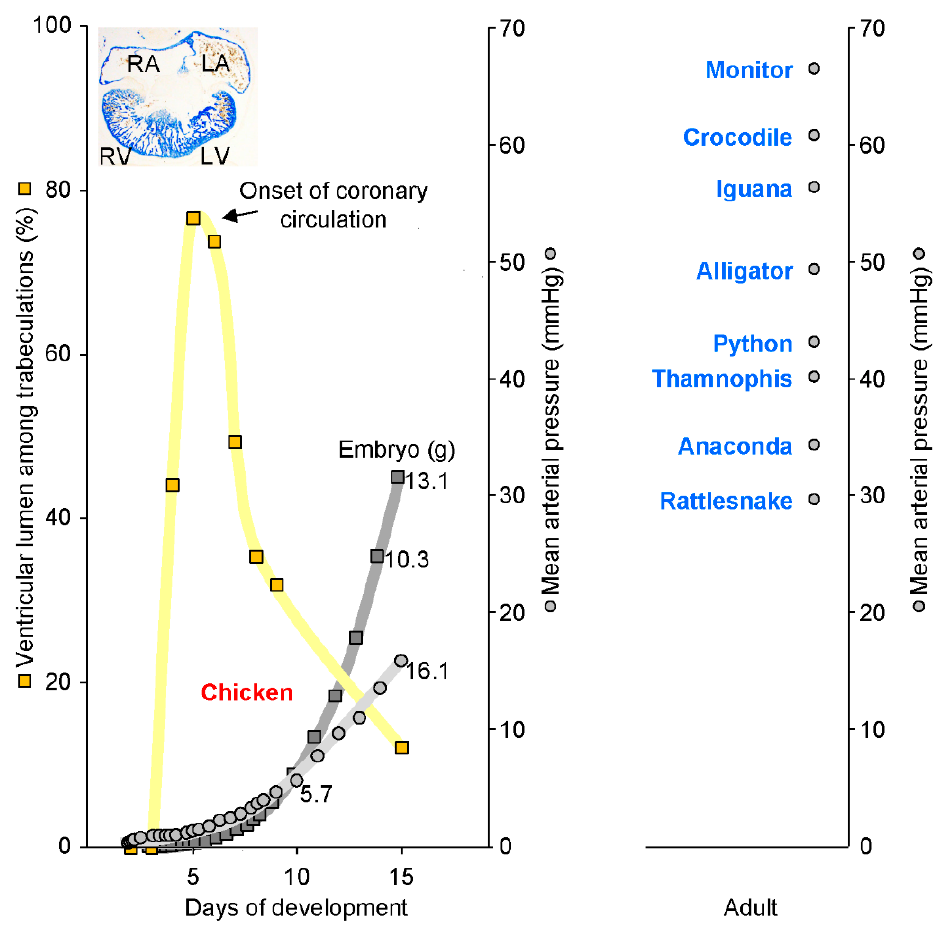
Figure 2. Highly trabeculated ventricles are capable of generating very substantial blood pressures. The left panel shows the in ovo development in chicken embryos of body mass (dark grey) and blood pressure (grey). In parallel, the wall architecture (yellow) changes from heart tube (2 to 3 days), to highly trabeculated (6 to 7 days), and to predominantly compact (15 days). The insert shows the highly trabeculated left (LV) and right ventricle (RV) at 6 days of development (and the almost a-trabecular left (LA) and right atrium (RA)). From approximately 6 days onwards, when blood pressure is about 3 mmHg, trabeculations and blood pressure become inversely related. The right-hand panel, however, shows that ectotherms have much greater blood pressures than developing chicken despite having highly trabeculated ventricles. Assuming that the cardiac mass is a fixed proportion of embryonic weight, which it is in a human [57], blood pressure will have a tight relation to cardiac mass (R 2 = 0.96, blood pressure and embryo weight). In the left panel, values for body mass and blood pressure are from Reference [58] and values for ventricular wall architecture are from Reference [45]. In the right panel, the blood pressures of python are from Reference [59] and the remaining values from Reference [60]).